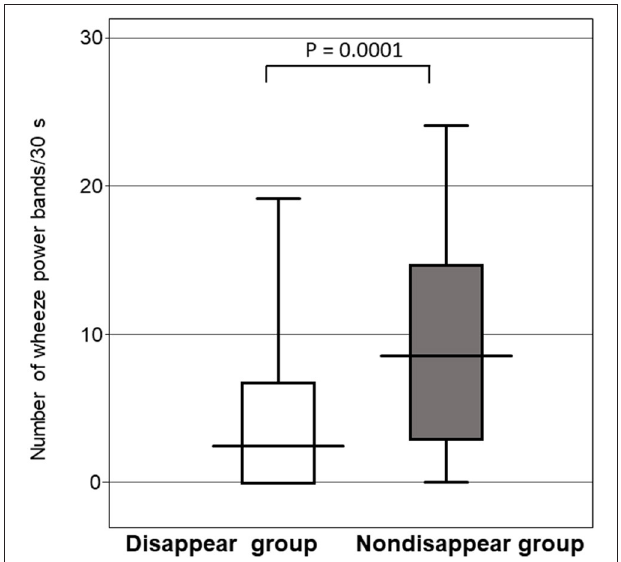
FIGURE 5 | Comparison of the number of wheeze power bands per 30s between the two groups. Horizontal line indicates the response to the inhaled β 2-agonist, and the error bars indicate the standard deviation. FIGURE 6 | Receiver operator characteristic curve analysis in response to the